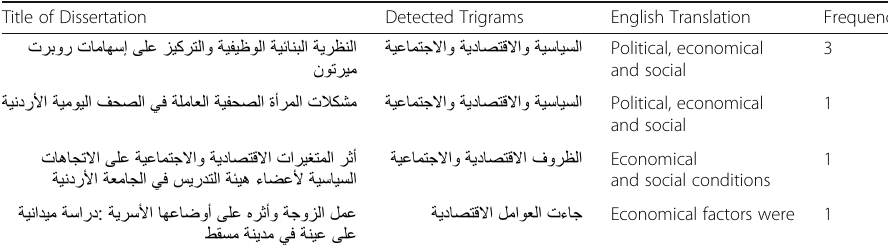
Table 10 Detected trigram